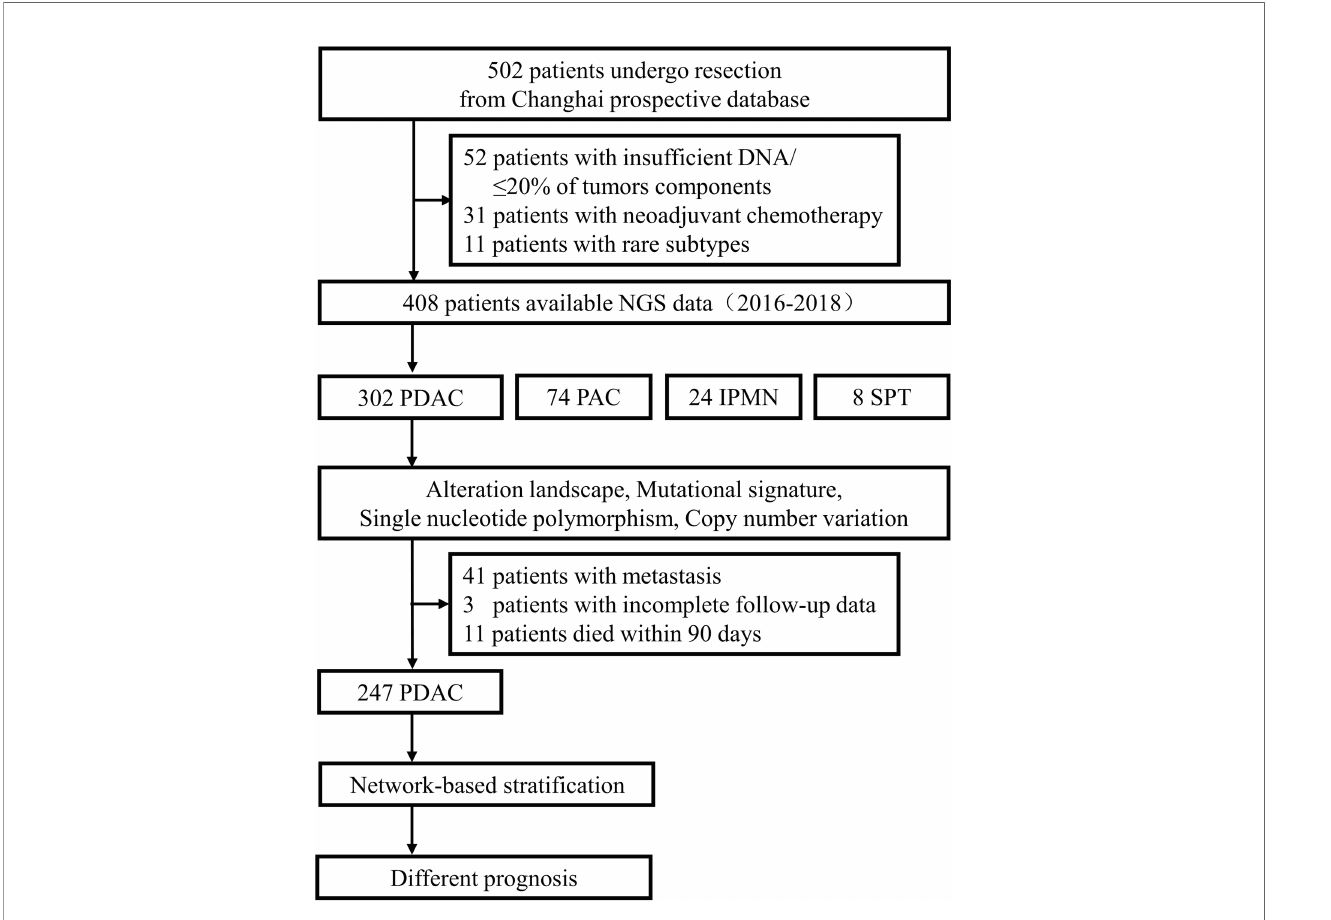
FIGURE 1 | Work fl ow diagram of the